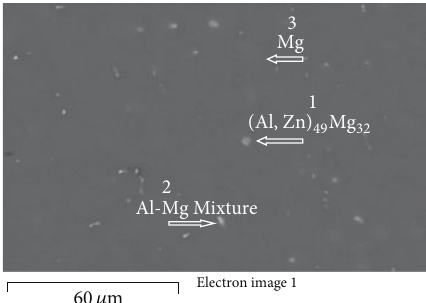
Figure 10: The effect of heat flux on the hardness of AZ31-B